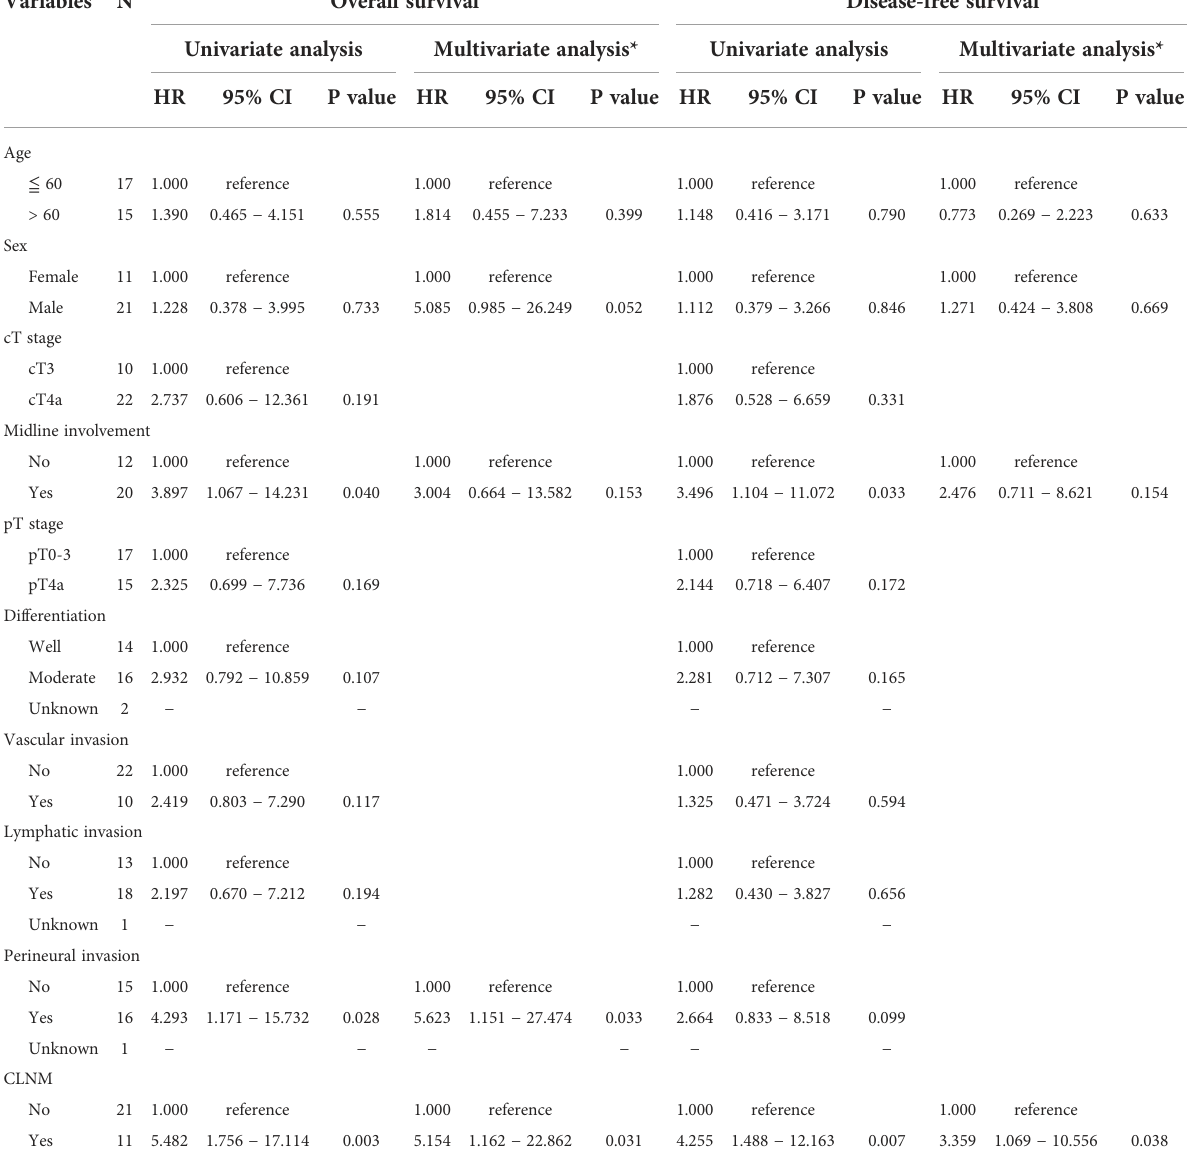
TABLE 4 Univariate and multivariate Cox regression analysis for factors predictive of overall survival and disease-free survival. Variables N Overall survival Disease-free survival Univariate